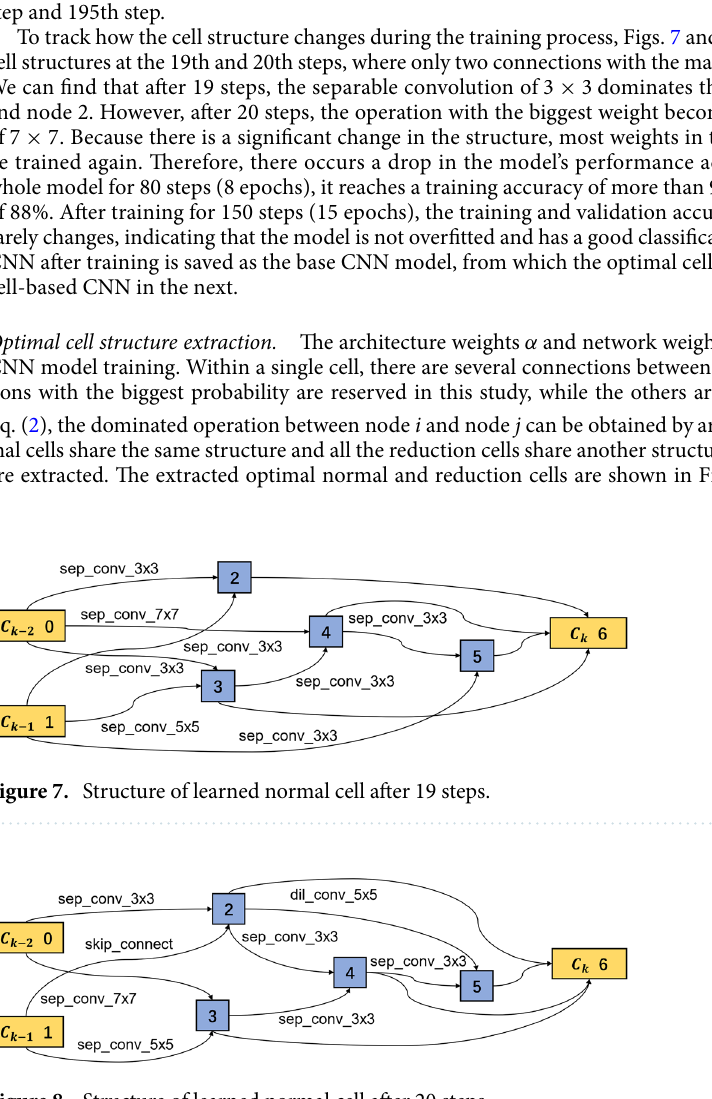
Figure 8. Structure of learned normal cell after 20